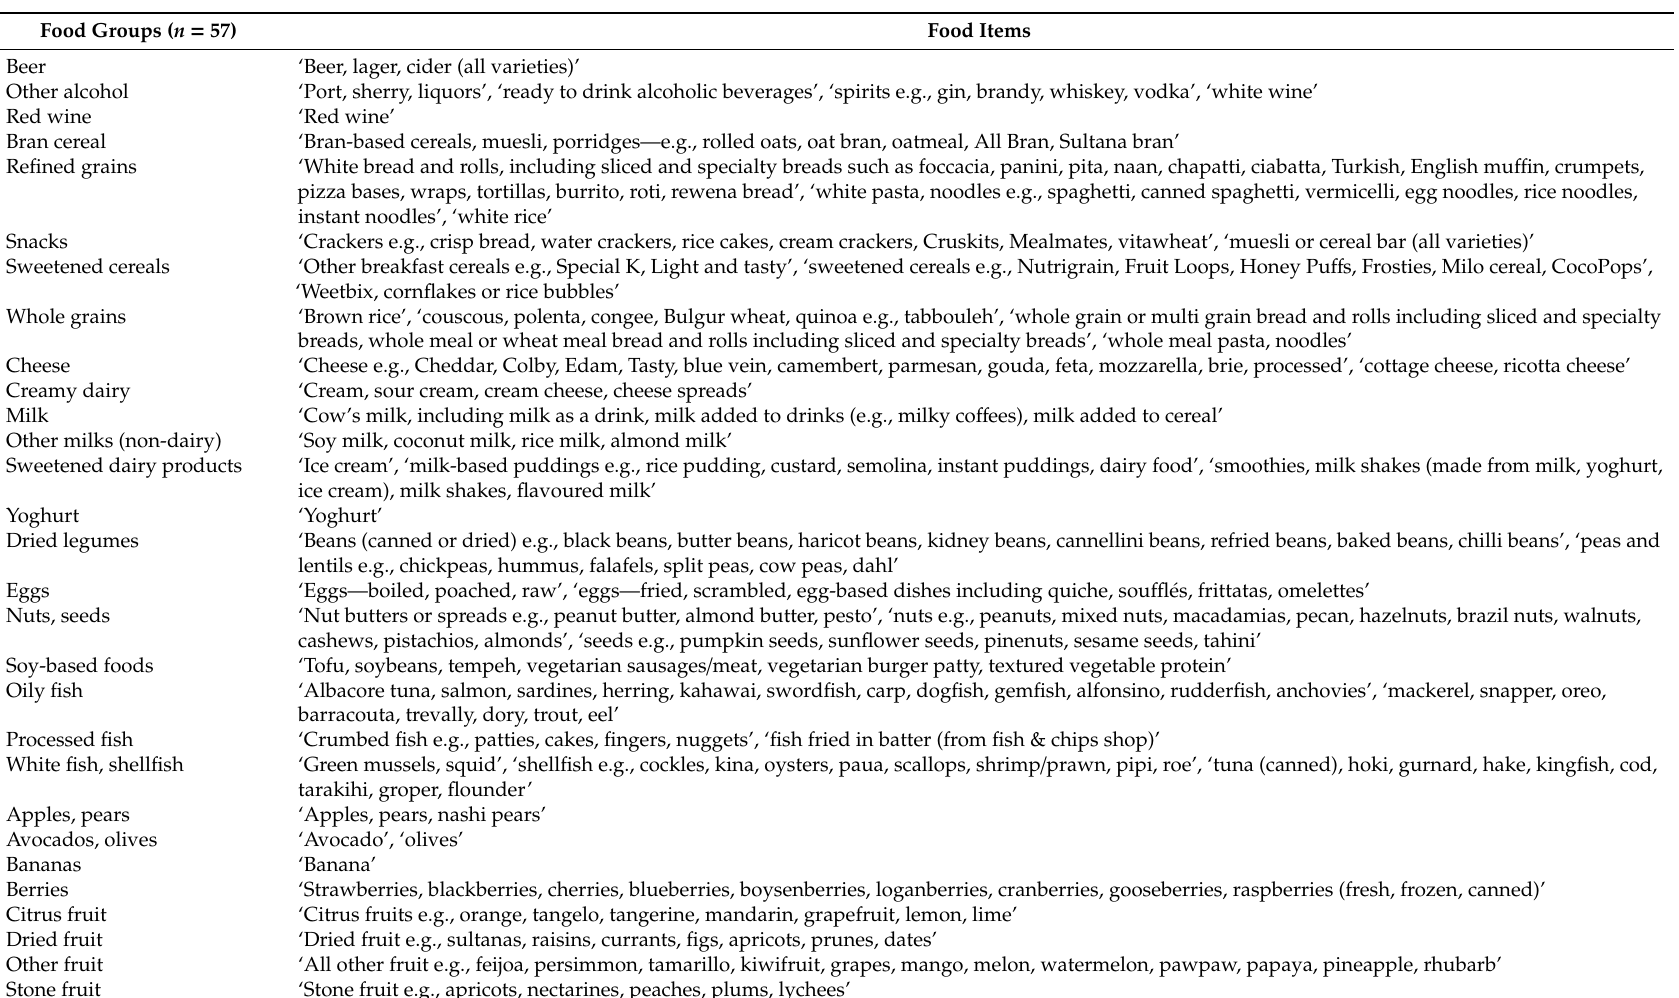
Table 1. Food groupings ( n = 57) used in the dietary pattern